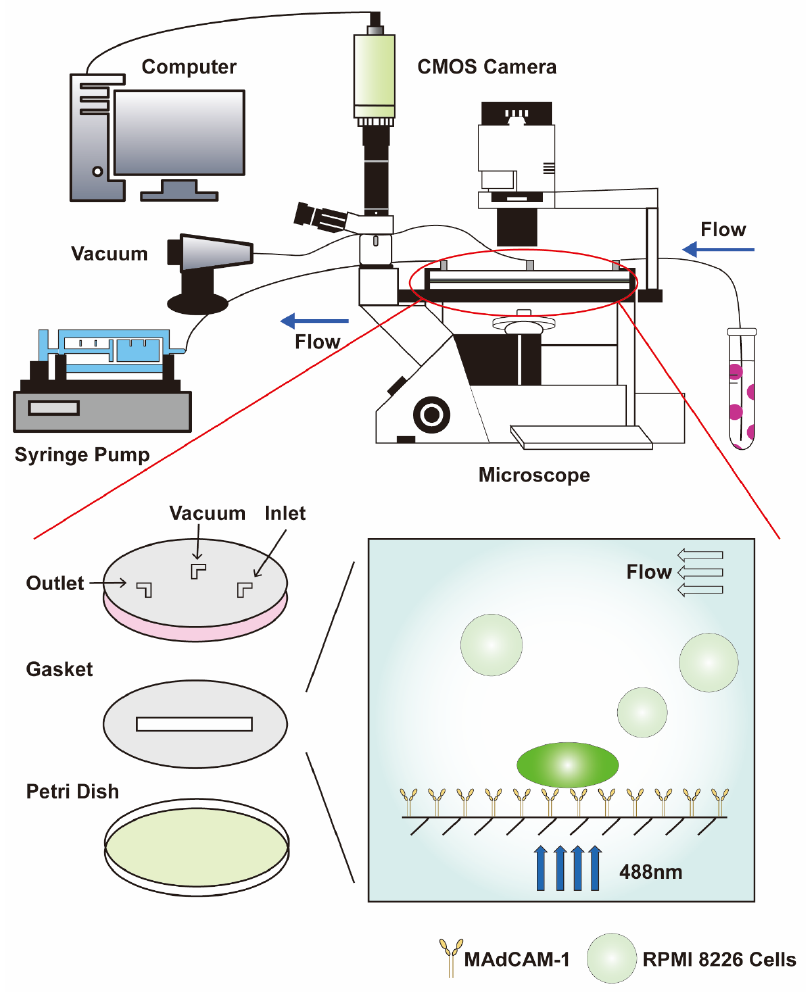
Figure 1. Schematic diagram of parallel plate flow chamber combined with a fluorescence detec- tion system. The dark green cell represents RPMI 8226 cells that adhere stably to the substrate of MAdCAM-1, whose calcium signaling is activated. The light green cell only slides across the surface of the substrate and comprises the background of calcium signaling. CMOS: complementary metal oxide semiconductor.